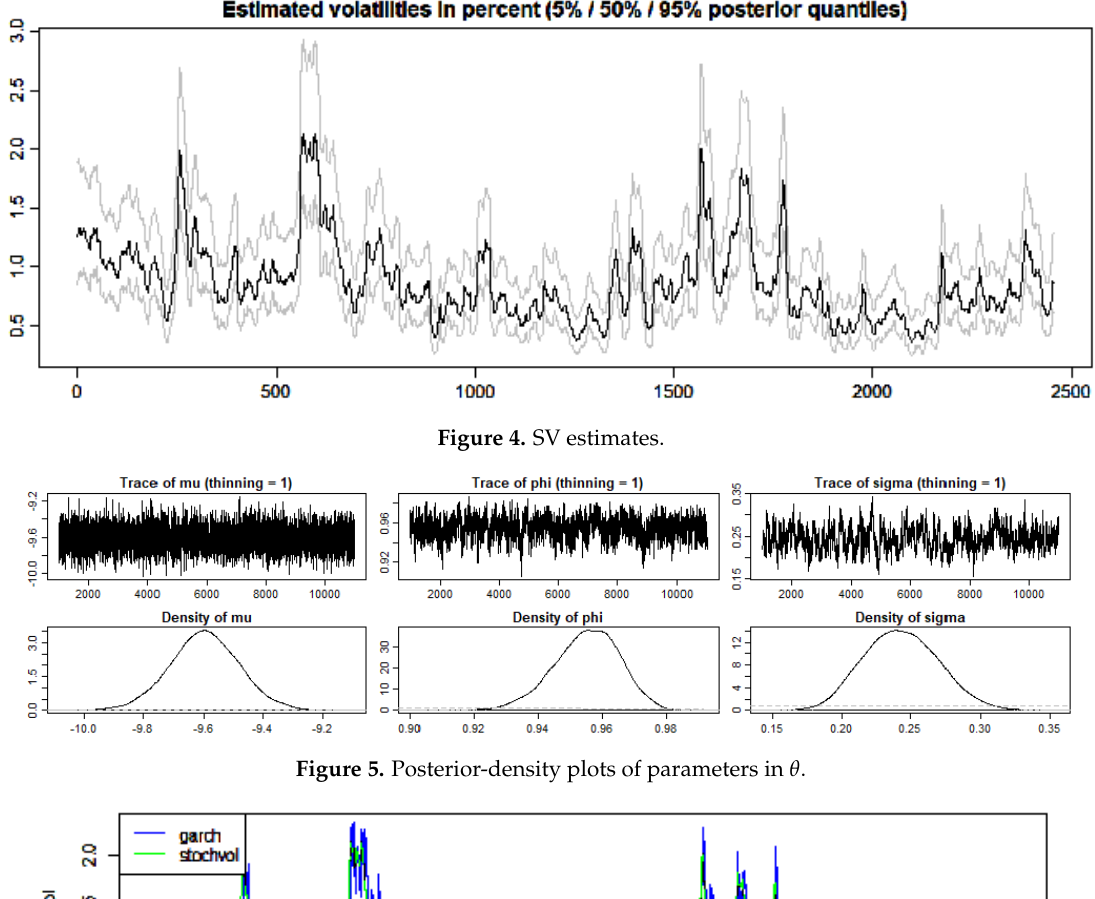
Figure 5. Posterior-density plots of parameters in θ .